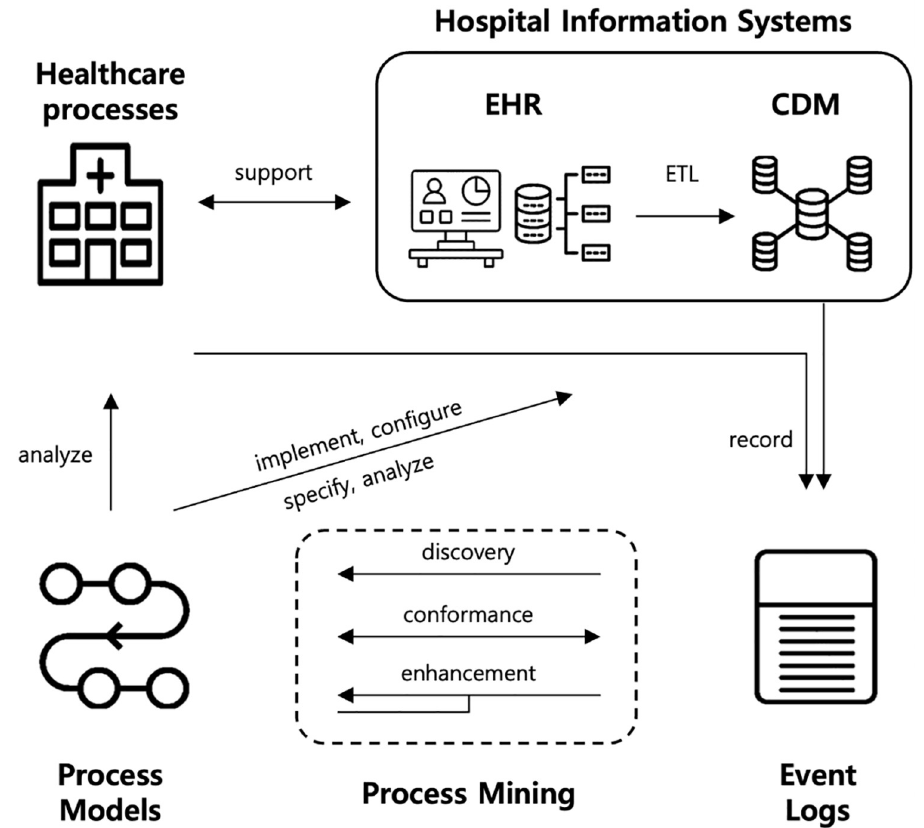
Fig 1. Process mining in the changing HIS environment (adapted based on [21,